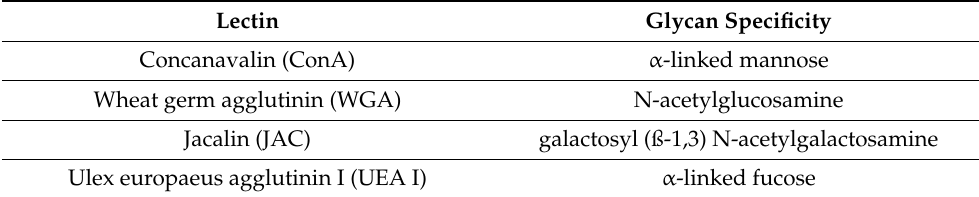
Table 2. List of lectins and their respective glycan